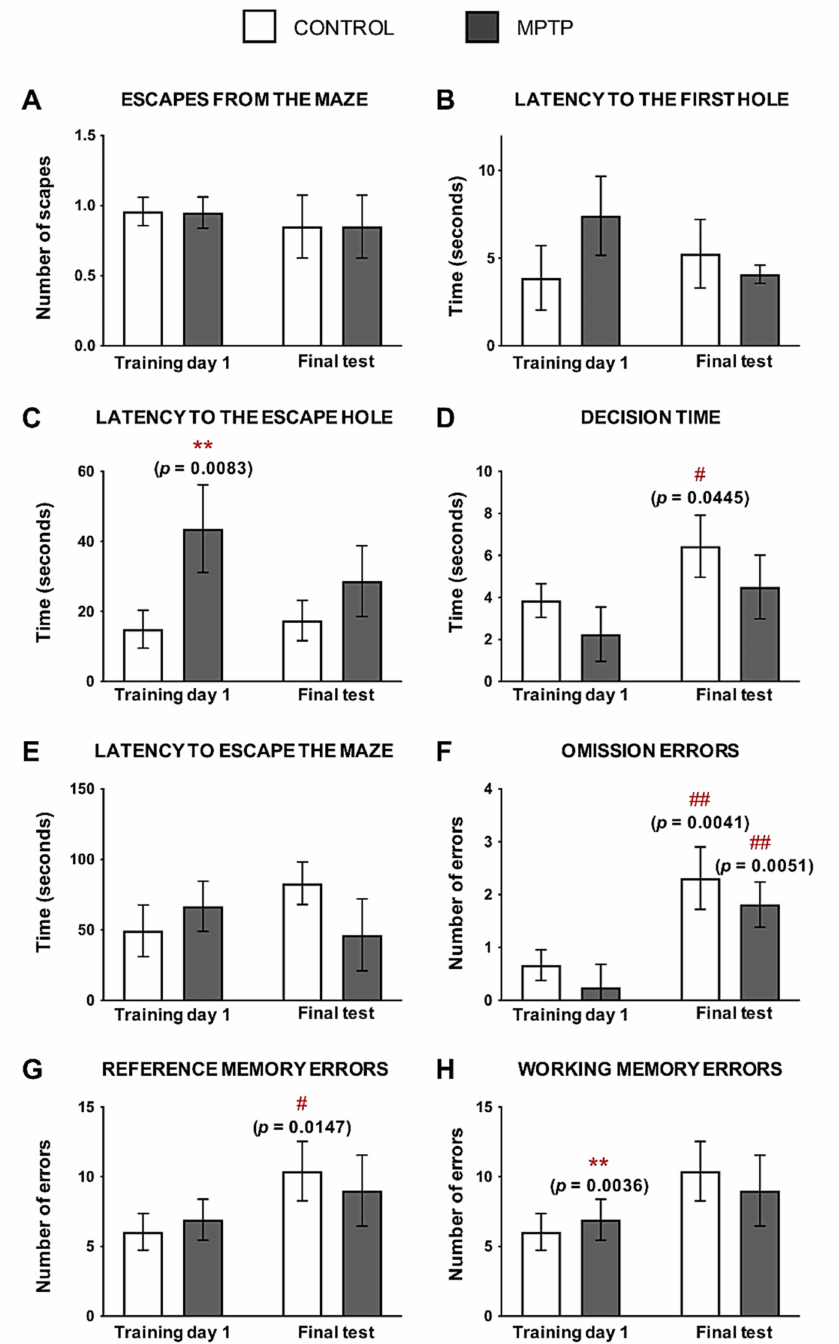
Figure 3. MPTP alters visuospatial memory in the O. degus . ( A ) Number of escapes from the maze. ( B ) Time spent (seconds) to find the first hole of the maze. ( C ) Time spent (seconds) to find the escape hole. ( D ) Time spent exploring the escape hole before leaving the maze. ( E ) Total time taken to escape the maze. ( F ) Number of visits to the escape hole without escaping through it. ( G ) Number of non-escape holes visited. ( H ) Number of repeated visits to non-escape holes. Data are expressed as mean ± SD; ** p < 0.01; Asterisks (*) indicate comparison between control and MPTP group in the same time point; pound sign (#) indicates comparison between the same group, different time point: control training day 1 vs. control final test and MPTP training day 1 vs. MPTP final test. # p < 0.05; ## p <